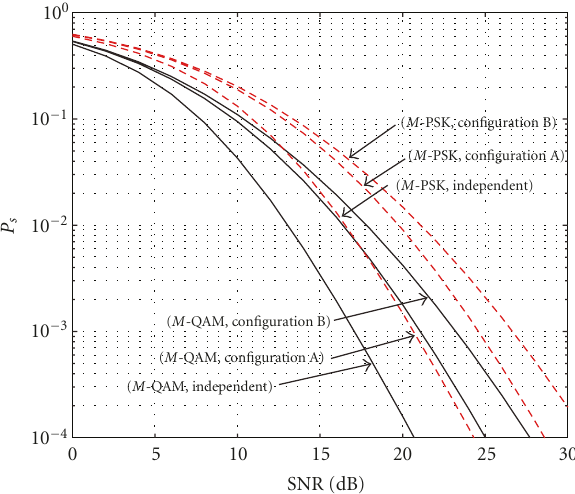
Figure 4: Average symbol error probability versus average SNR per bit for M -QAM and M -PSK signals ( M = 16) with K = 3, Nakagami- m fading channel ( m = 1) for both independent and dependent channels cases.